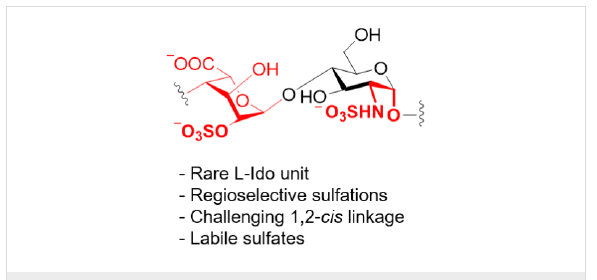
Figure 17: Synthetic challenges associated to the H/HS